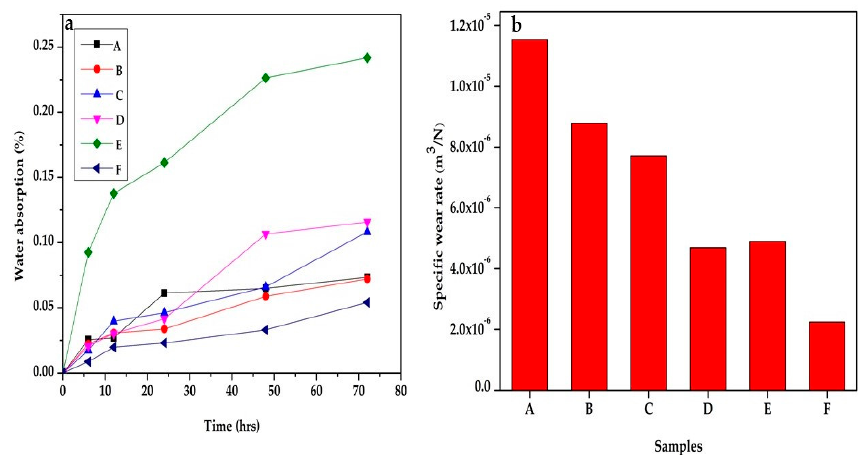
Figure 8. ( a ) Wear and ( b ) water absorption properties of samples A—92% polylactic acid (P)/8% chitin (C); B—92% P/6% C/2% starch (S); C— 92% P/4% C/4% S; D—92% P/2% C/6% S; E—92% P/8% S; F—100% P.